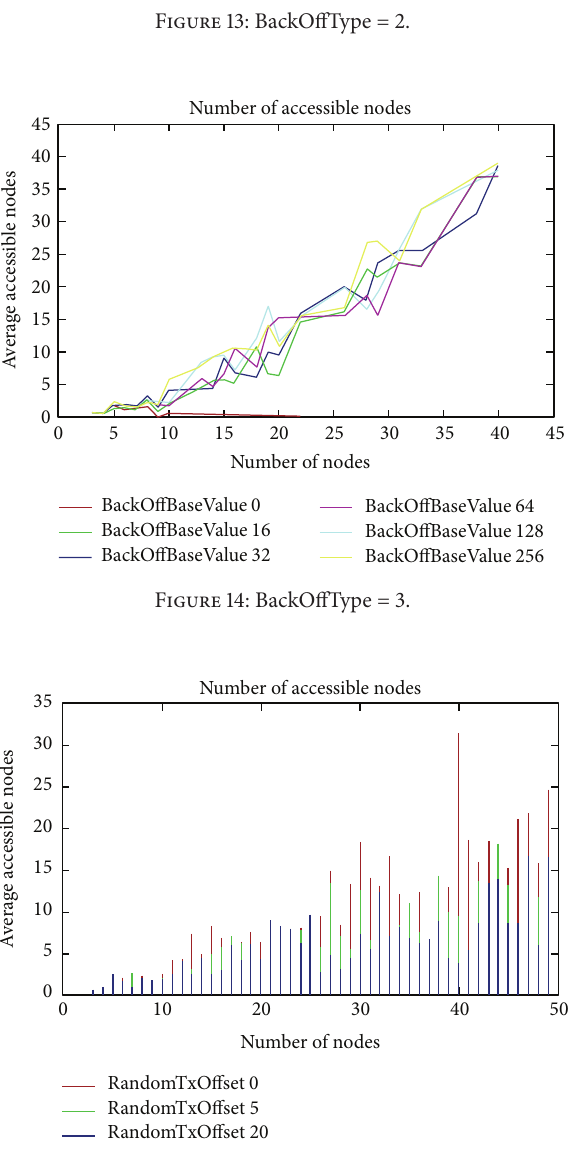
Figure 13: BackOffType = 2.